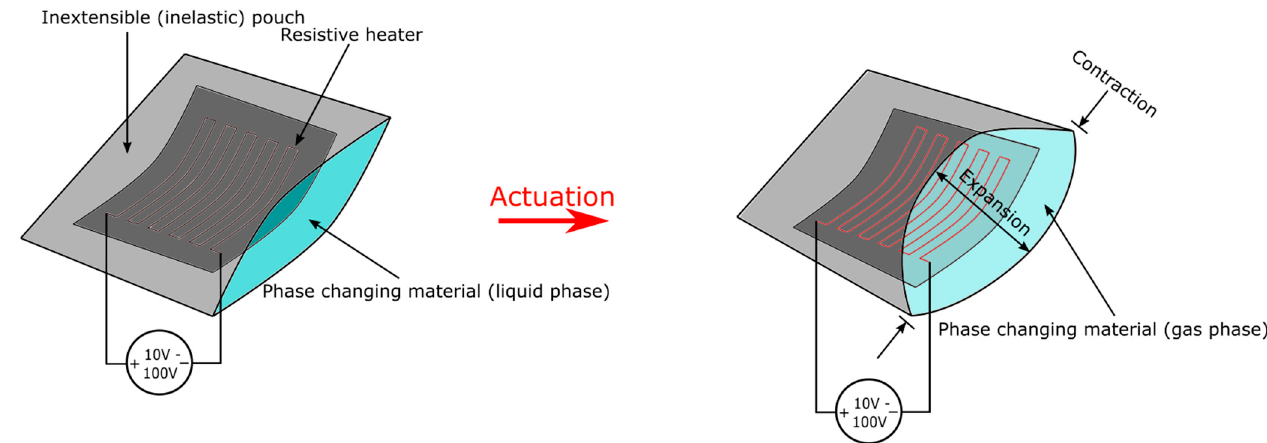
Figure 9. The actuation scheme of the STAT actuator. A resistive heater is embedded within the actuator, and power of 6 W is required to heat up the actuator. Since the pouch is inelastic, vaporization of the changing material will bulge the pouch.